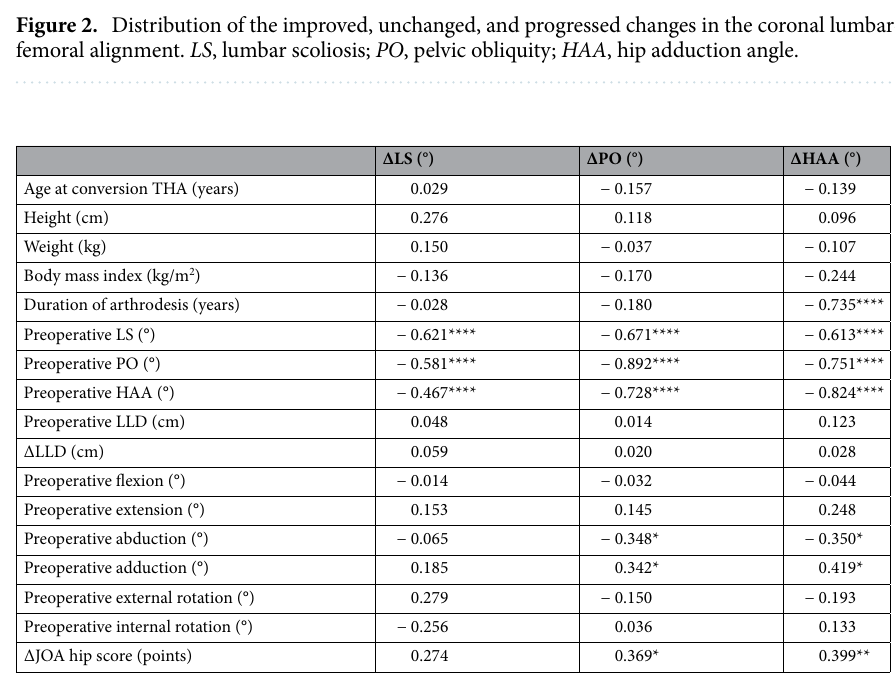
Table 3. Pearson’s or Spearman’s correlation between the change in the coronal lumbar-pelvic-femoral alignment after conversion to THA and possible associated factors. THA , total hip arthroplasty; LS , lumbar scoliosis; PO , pelvic obliquity; HAA , hip adduction angle; JOA , Japanese Orthopaedic Association. ΔLS : the difference between the LS before and after surgery. ΔPO : difference between the PO before and after surgery. ΔHAA : difference between the HAA before and after surgery. ΔJOA hip score : difference between the JOA hip score before and after surgery. Pearson’s correlation coefficient was calculated for variables without shade, and Spearman’s correlation coefficient was calculated for variables with shade. * p < 0.05, ** p < 0.01, *** p < 0.005, **** p <